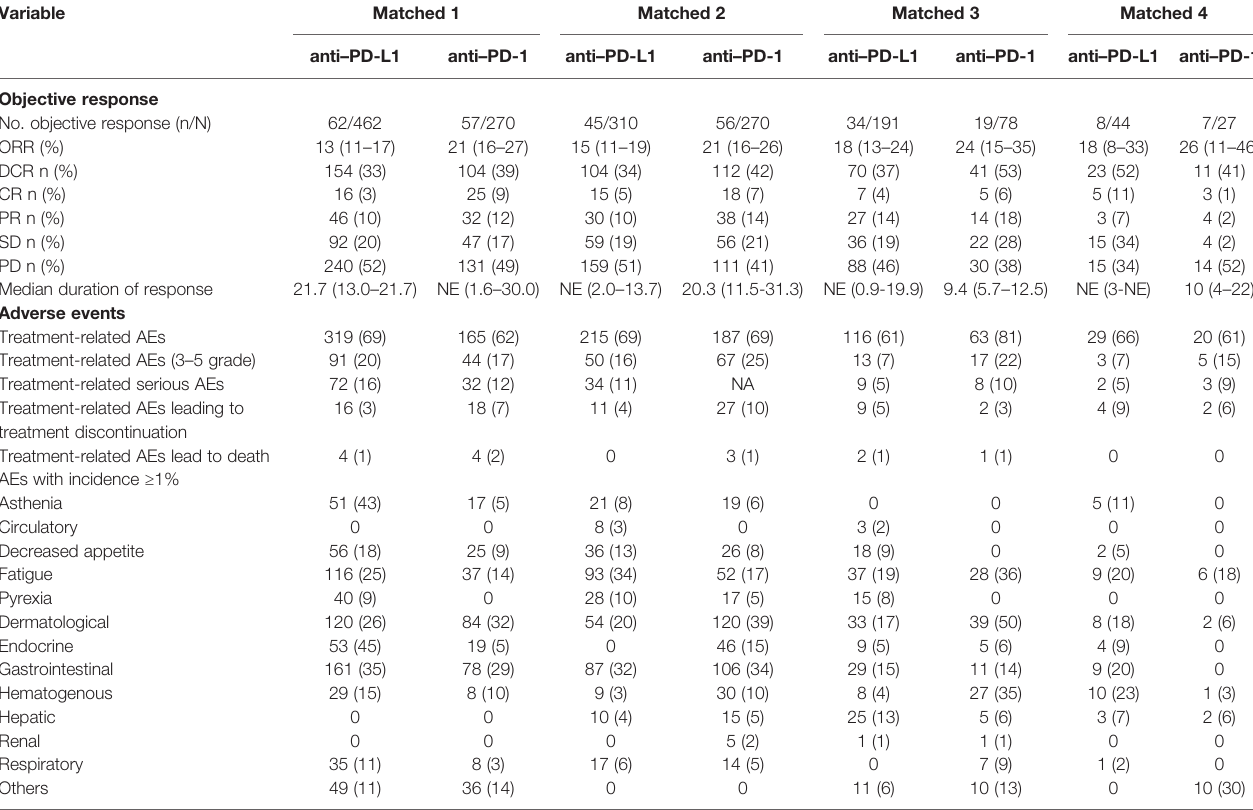
(1) Circulatory: atrial fi brillation, cardiorespiratory arrest, hypertension, hypotension, myocarditis (2); dermatological: alopecia, dermatitis acneiform, dry mouth, maculopapular, mucosal in fl ammation, skin reactions, pruritus, rash, stomatitis, tumor fl are, uveitis (3); endocrine:adrenal disorder, diabetes, hypothyroidism, hypophysitis, hyperthyroidism, hypersensitivity, hyperglycemia,pituitarydisorder,rheumatoidarthritis,thyroiddisorder;(4)gastrointestinal:abdominalpain,colitis,constipation,diarrhea,intestinalperforation,increasedamylase,nausea, pancreatitis, vomiting(5);hematogenous:anemia, bloodalkalinephosphatase increased,creatine phosphokinase,dehydration, hyponatremia,increased bloodALPlevel,Infusion-related reaction, leukocyte count decreased, lipase elevated, lymphocyte count decreased, neutropenia, thrombocytopenia (6); hepatic: alanine aminotransferase increased, amylase increased, aspartateaminotransferaseincreased,bloodbilirubinincreased,hepatitis(7);renal:nephritis,renalfailure,urinarytractobstruction(8);respiratory:cough,dyspnea,interstitiallungdisease, pneumonitis, respiratory tract infection, respiratory failure, wheezing (9); others: arthralgia, dysgeusia, edema peripheral, muscle spasms, myalgia, myositis, neuromyopathy, pain, paresthesia, peripheral sensory neuropathy, peripheral sensory neuropathy, rhabdomyolysis, toxic